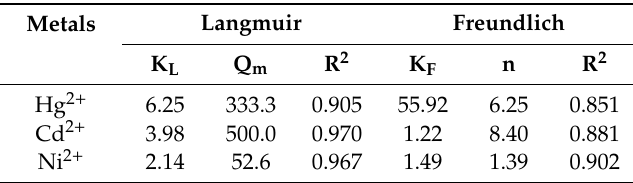
Figure 8. Adsorption isotherms model (Co wt % = 40%). ( a , c , e ) Langmuir isotherm for Hg 2 + , Cd 2 + , and Ni 2 + ; ( b , d , f ) Freundlich isotherm for Hg 2 + , Cd 2 + , and Ni 2 + . Table 3. Adsorption isotherm